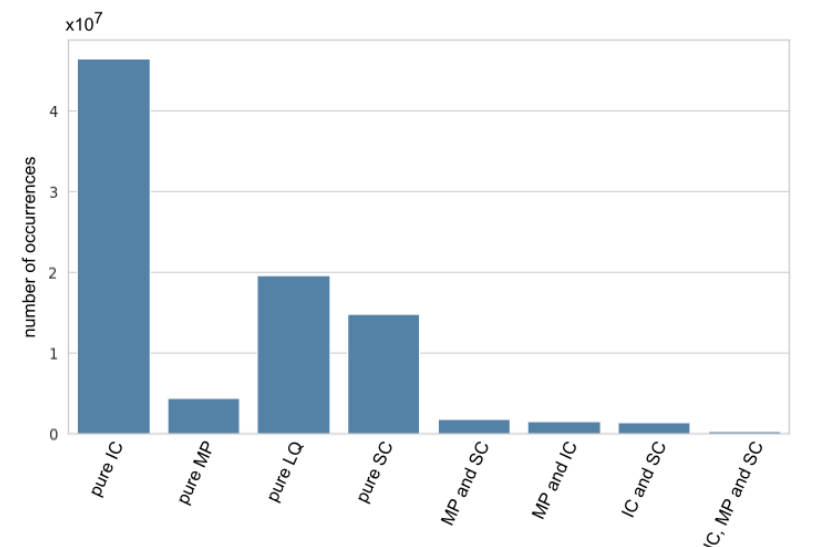
Figure A1. Number of occurrences of the different possible phase combinations in the vertical band of 240 m in DARDAR resolution. The four leftmost bars (“pure IC”, “pure MP”, “pure LQ” and “pure SC”) mean that the vertical band contains only gates of the respective phase. The four rightmost bars (“MP and SC”, “MP and IC”, “IC and SC” and “IC, MP and SC”) mean that gates of the respective two or three phases are contained in the vertical band. Hence, the four rightmost bars all fall under the MP category in the vertical aggregation step, as described in Section